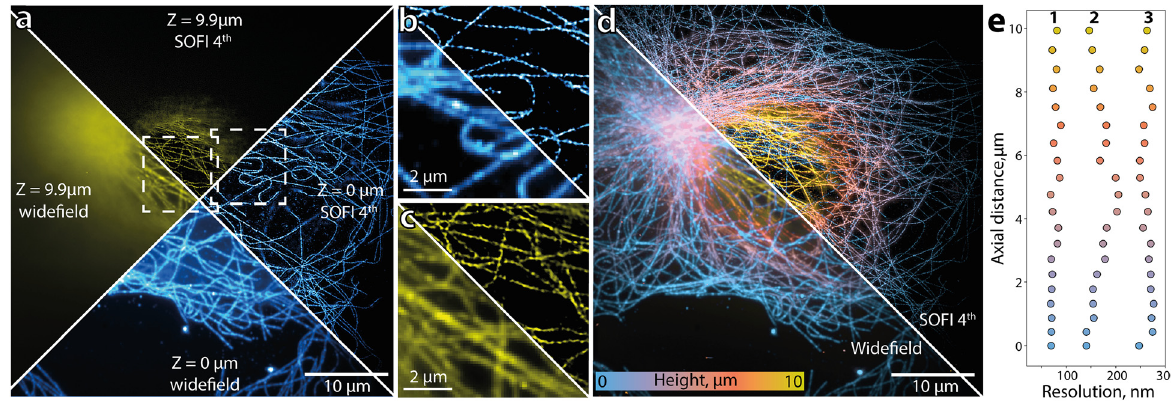
Figure 2: Sequential-plane imaging with SOFI. (a)ImagesoftubulinofaCOS-7cellimmunostainedwithAbberiorFLIP-565self-blinkingdyeacquiredfromdifferentheightsof0µm(blue)and 9.9 µm (yellow). A comparison of a wide fi eld and SOFI 4th order images recorded at 0 µm (b) and 9.9 µm (c) indicates a clear contrast and resolution improvement provided by SOFI. (d) An overlay of 20 planes spaced with approx. 500 nm axial distance. (e) Lateral resolution dependency on height for different SOFI orders (1 – SOFI 4th, 2 – SOFI 2nd, 3 – wide fi eld).